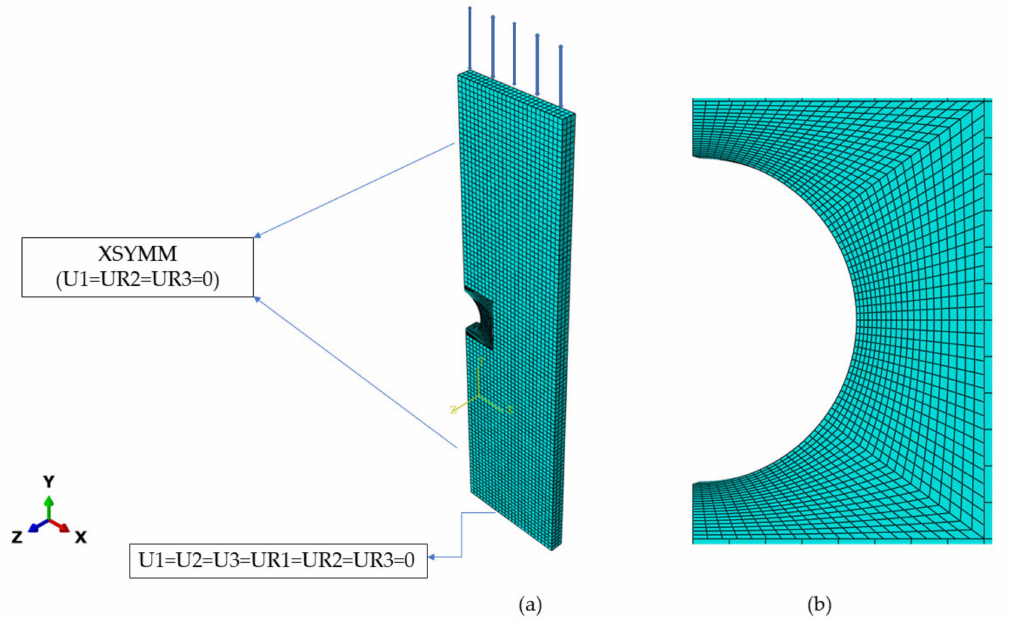
Figure 4. ( a ) Meshed specimen loaded axially along Y -axis and boundary conditions, ( b ) Meshing at the vicinity of notch root through quadratic elements.